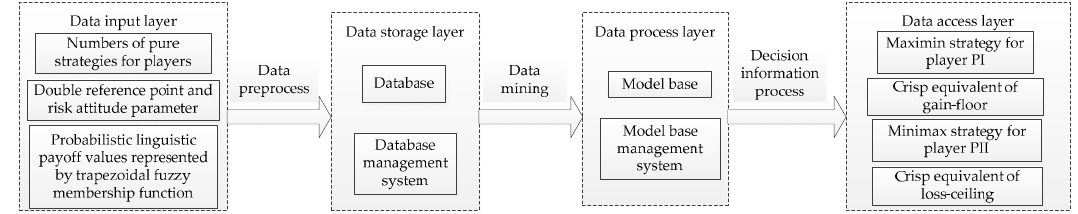
Figure 14. Framework of DSS based on the proposed method.